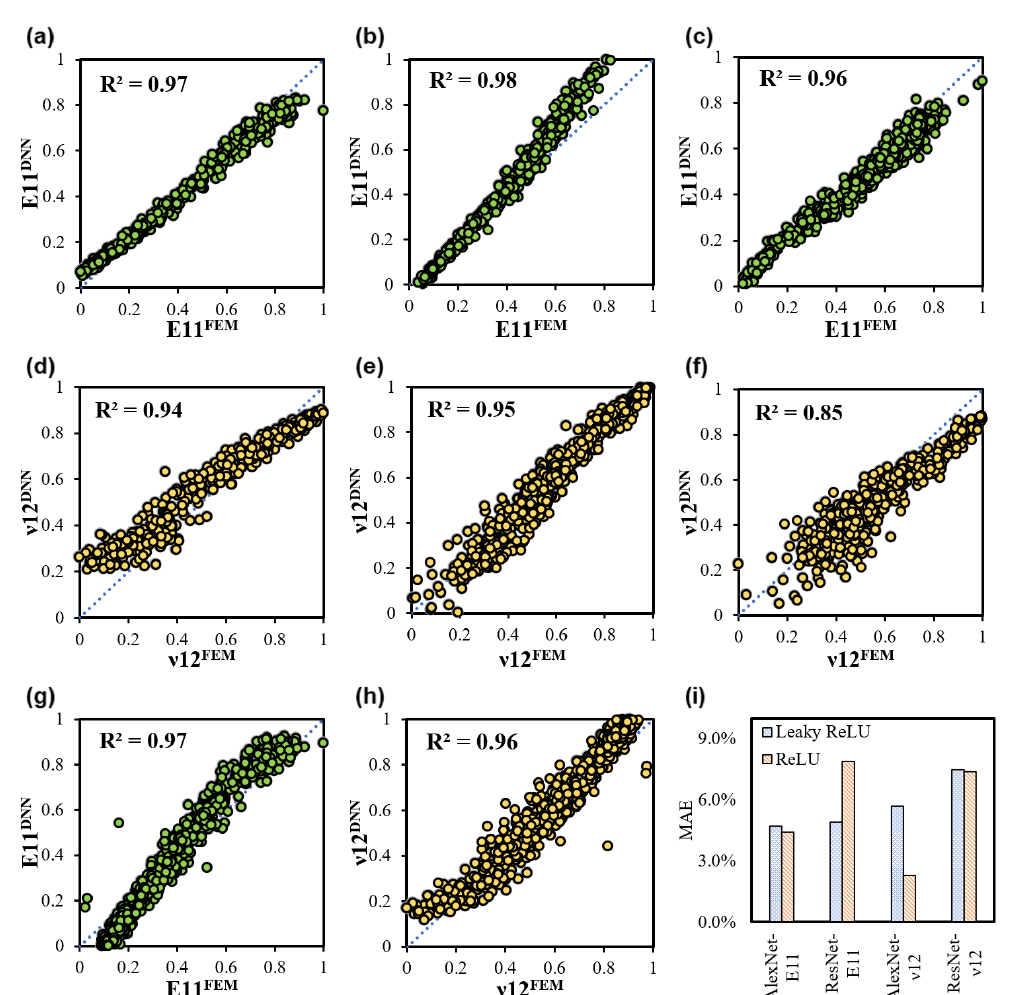
Figure 3. Performance of the ResNet model in extracting the elastic property of the composite hydrogel including the Young’s modulus (E11) and Poisson’s ratio ( ν 12) on the ( a , d ) uniform dataset, ( b , e ) non-uniform dataset, ( c , f ) irregular dataset, and ( g , h ) full dataset. ( i ) Comparison of the ReLU and Leaky ReLU activation function performance in terms of MAE for ResNet and AlexNet on the full dataset.